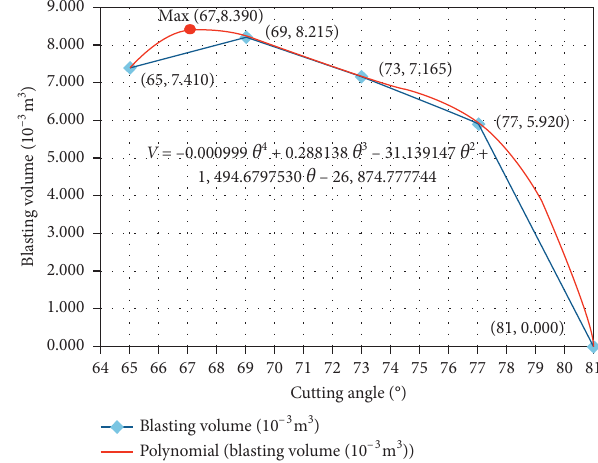
Figure 7: Fitting curves of wedge cutting models with different angles and cutting depth.